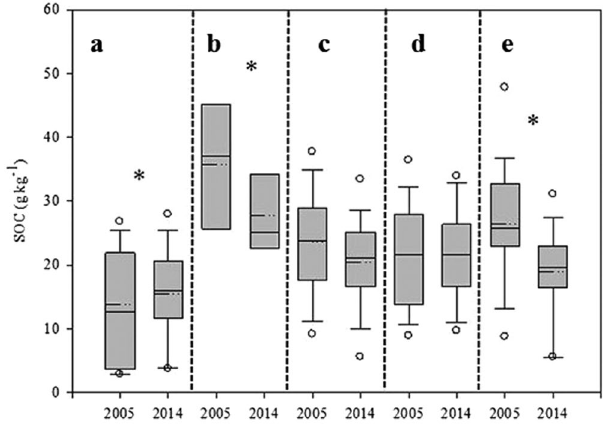
Figure 1. Soil organic carbon changes from 2005 to 2014 in response to different cropping systems. ( a ) Corn monocropping (C-C, n = 20), ( b ) soybeans monocropping (S-S, n = 5), ( c ) break crop (S-C, n = 55). ( d ) Corn/ soybean ≥ 1 (S-C 1 , n = 34). ( e ) Corn/soybean from 0 to 1 (S-C 2 , n = 21). Between each cropping system, means followed by asterisk are significantly different ( P <